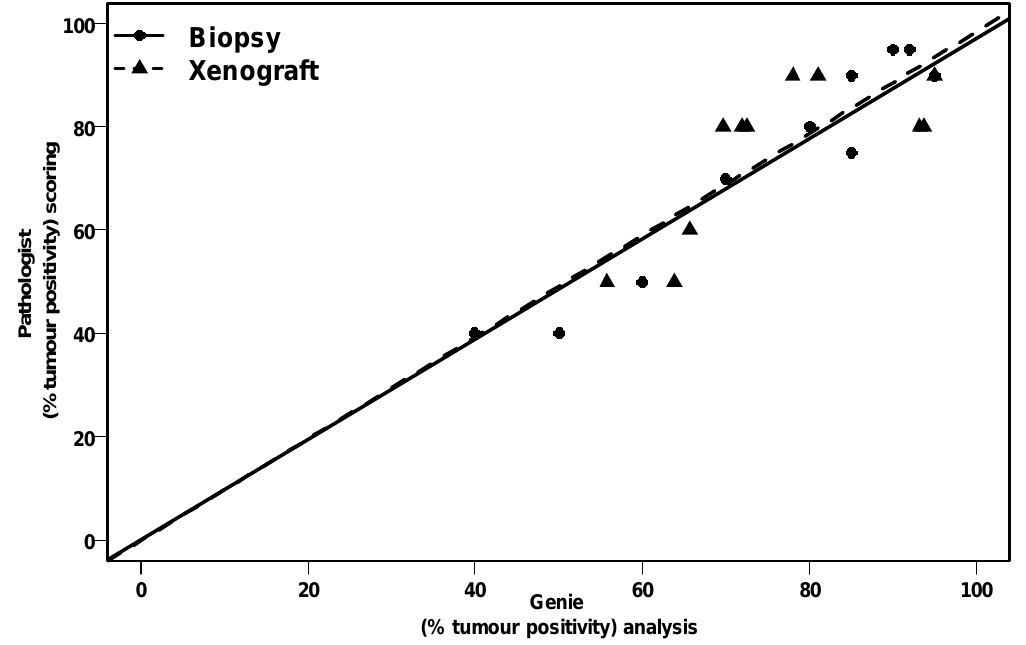
Figure 3. Linear plot regression analysis showing the association of percent tumor epithelial component from the pathologist scoring vs. Genie Spectrum software on patient cervix biopsies and xenograft. Scoring was conducted on the H&E slides with n = 1 slide for the biopsy ( p = 0.0001) and n = 3–4 for the xenografts ( p = 0.0099).